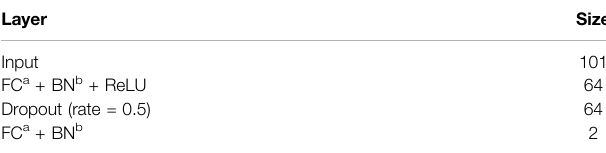
TABLE 2 | Description of the adopted neural network model.